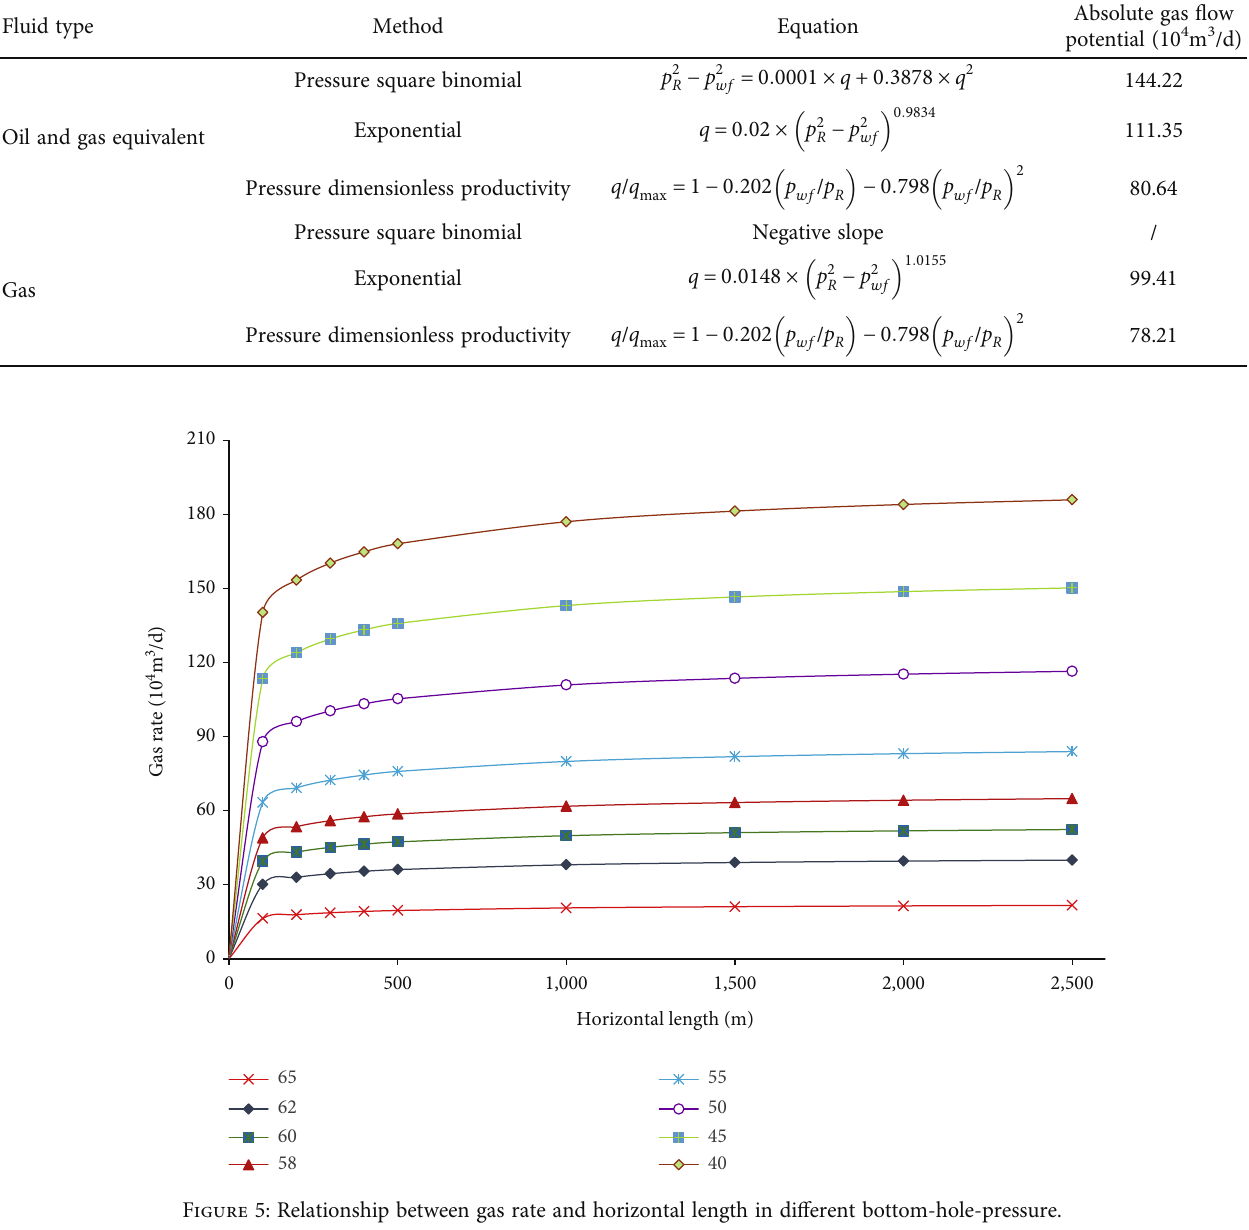
Table 3: Gas well production results by di ff erent methods.